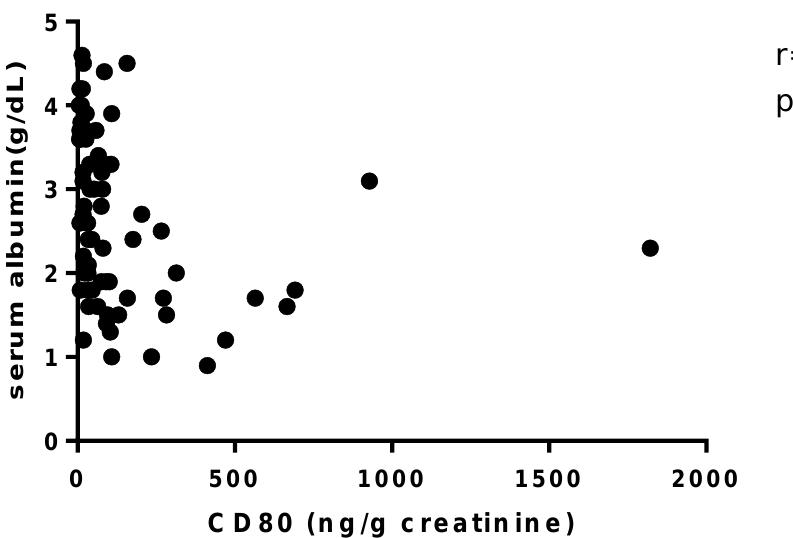
Figure 1. Correlation between urinary CD80 adjusted for urinary creatinine and baseline serum albumin.